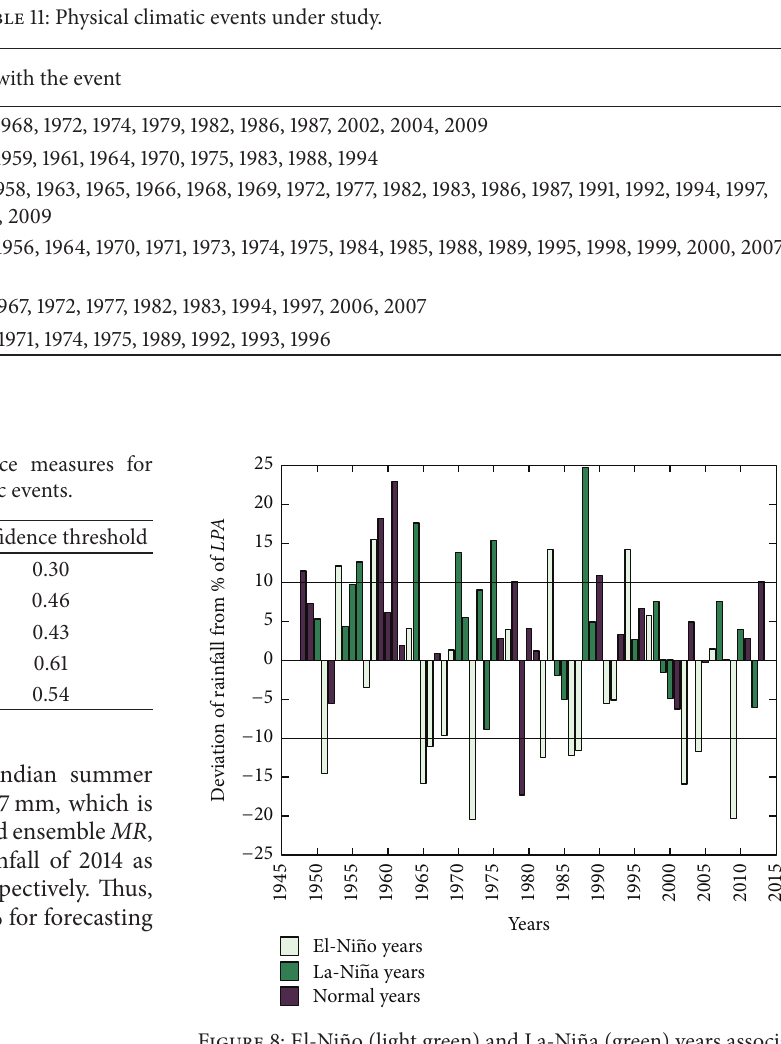
Figure 8: El-Ni˜no (light green) and La-Ni˜na (green) years associa- tion with drought (years below 10% of LPA rainfall), normal (years between +10% and − 10% of LPA rainfall), and excess (years above 10% of LPA rainfall) years during period